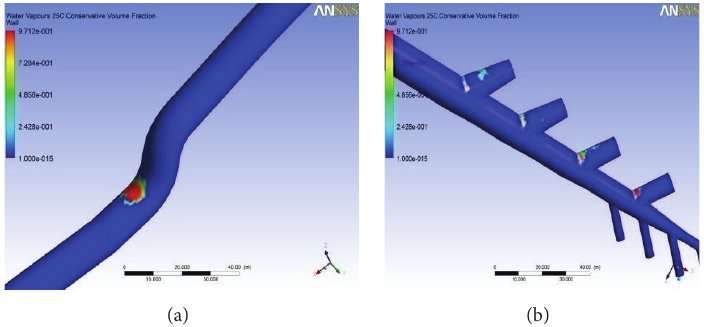
Figure 6: Cavitation erosion (water vapors) at different locations of Tunnel